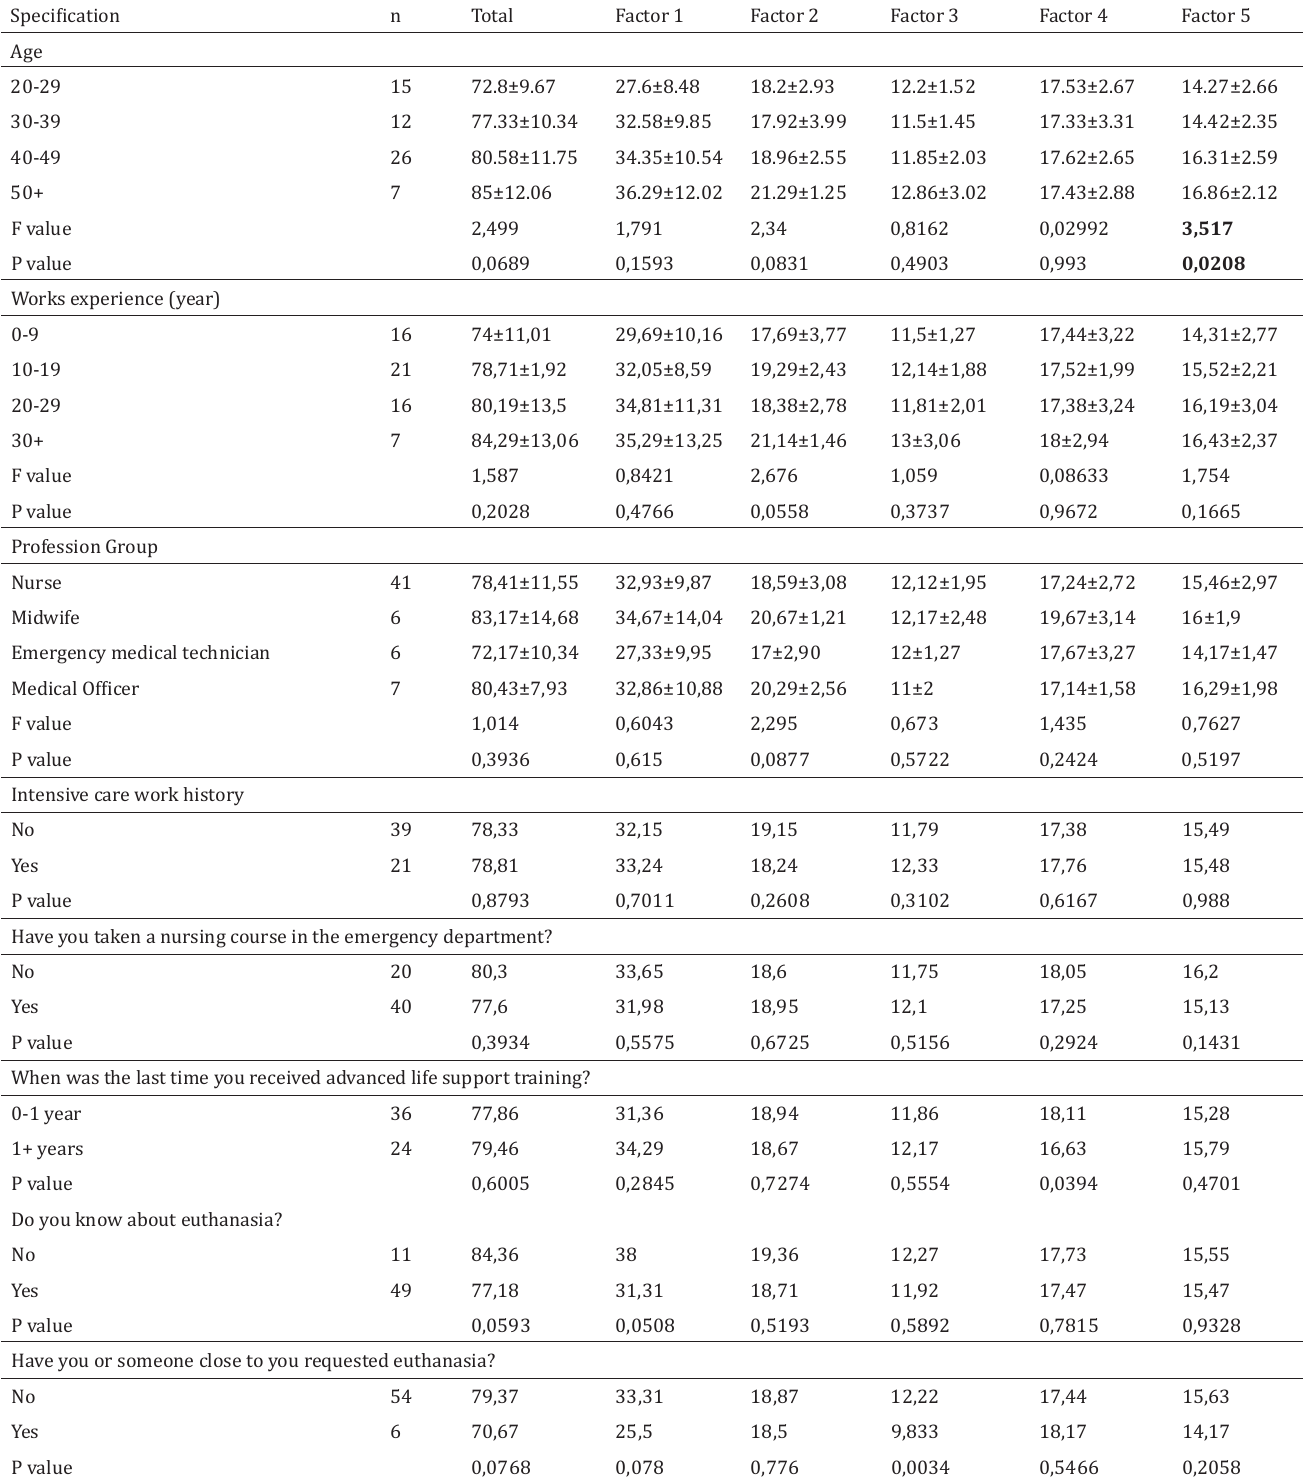
Attitude scale towards euthanasia, death and the terminally illness score and comparison of the answers according to the